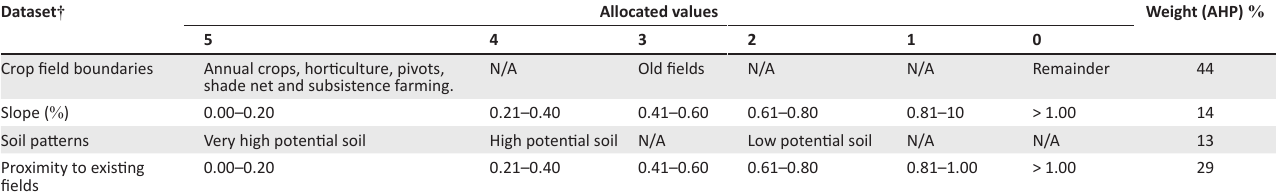
TABLE 3: Agricultural